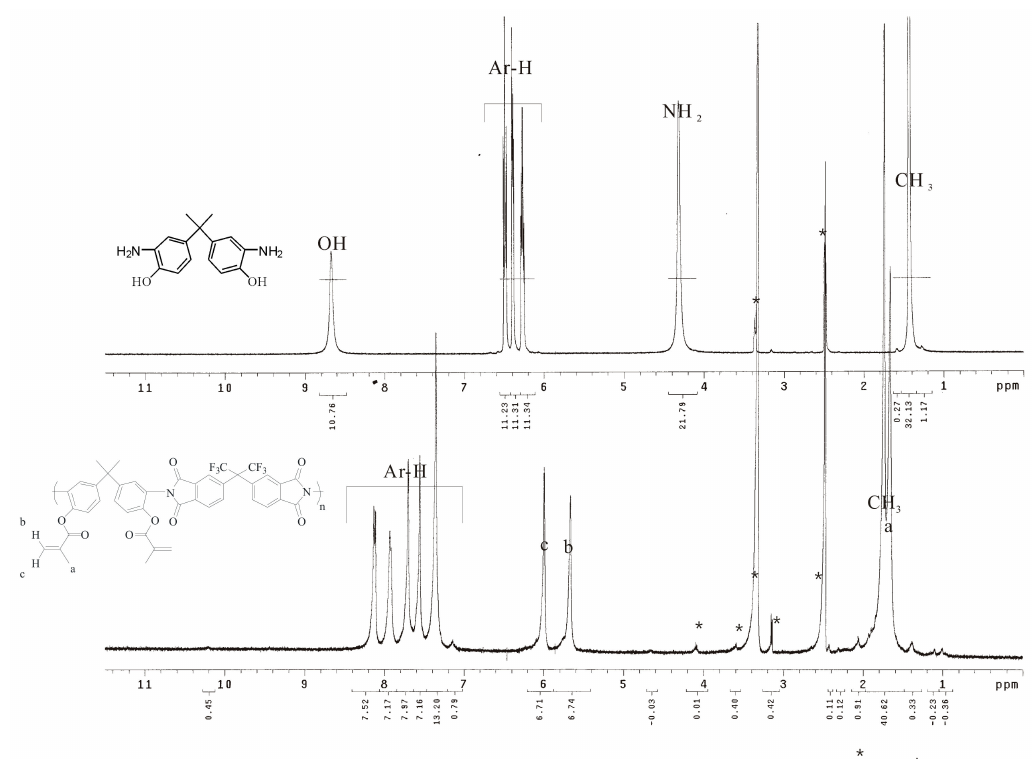
Figure 2. 1 H-NMR spectra of hydroxyl diamine (2) and P2–MMA in DMSO- d 6 . (*: Solvents).